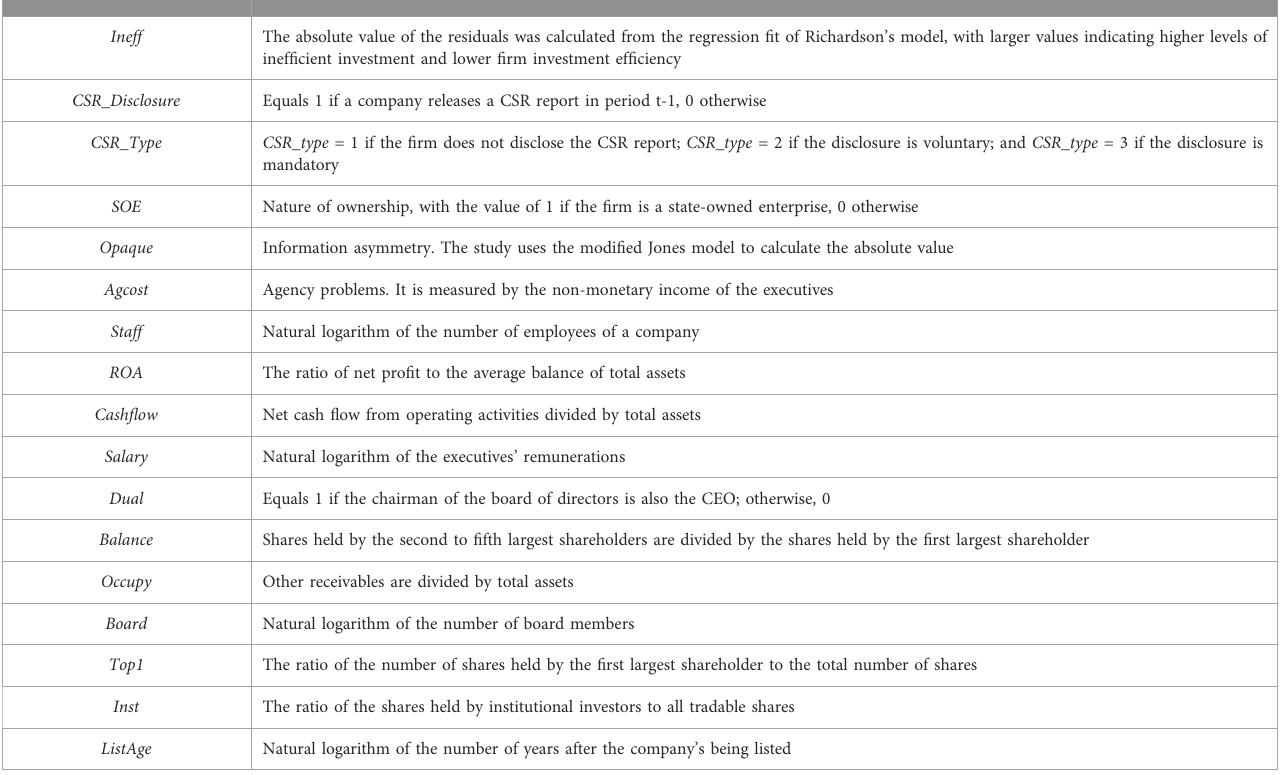
TABLE 2 De fi nition of variables. Variable De fi